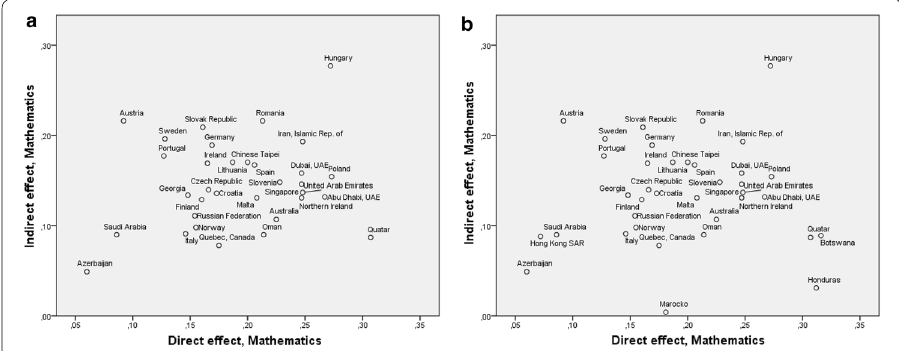
Fig. 2 Scatter plot of the relations between direct and indirect effects of Parental Education on Mathematics. a Without outliers, b With